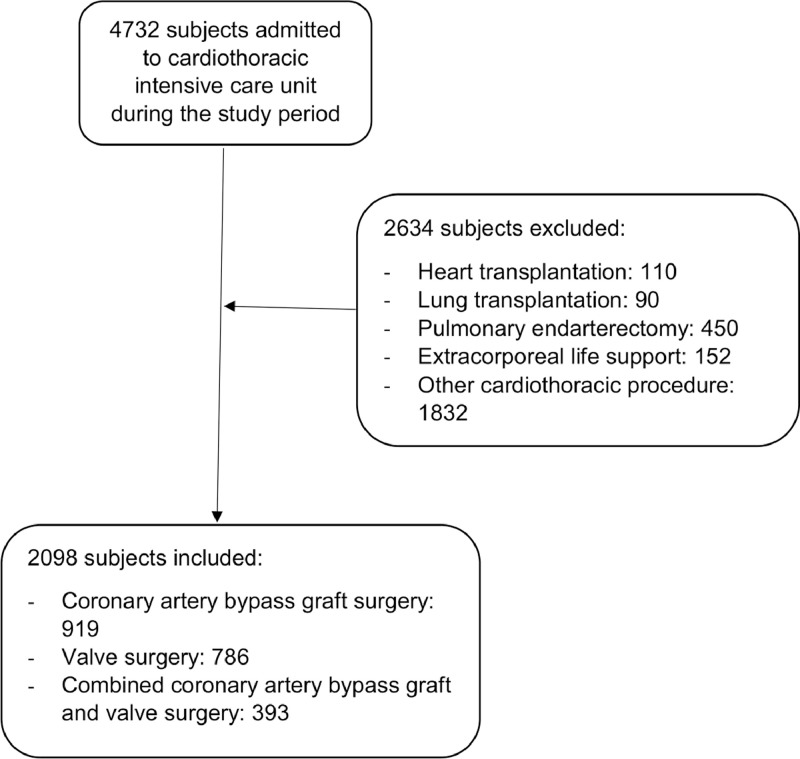
Flow diagram of study population.